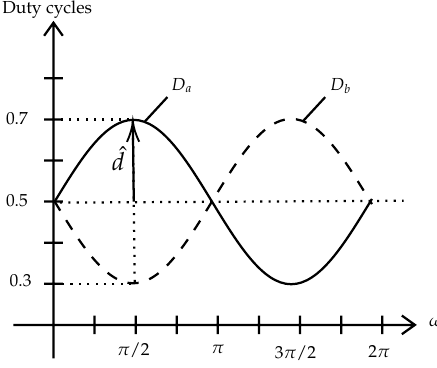
Figure 3. Boost inverter waveform